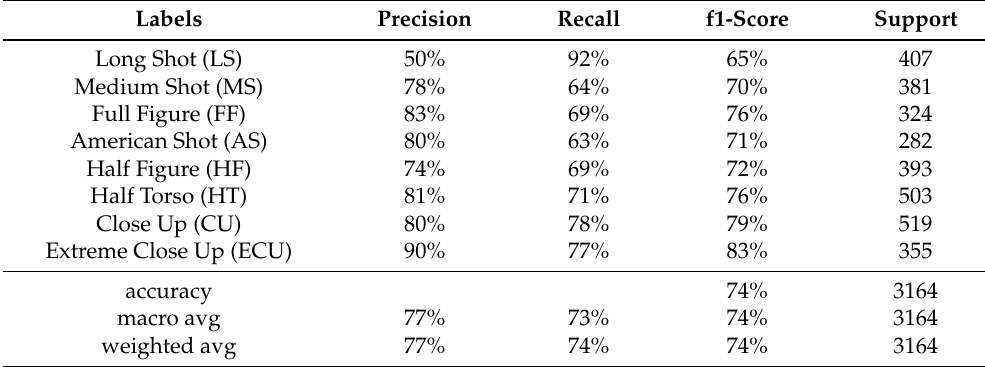
Table 18. Precision recall and f1-score of a random forest on the predictions of the three